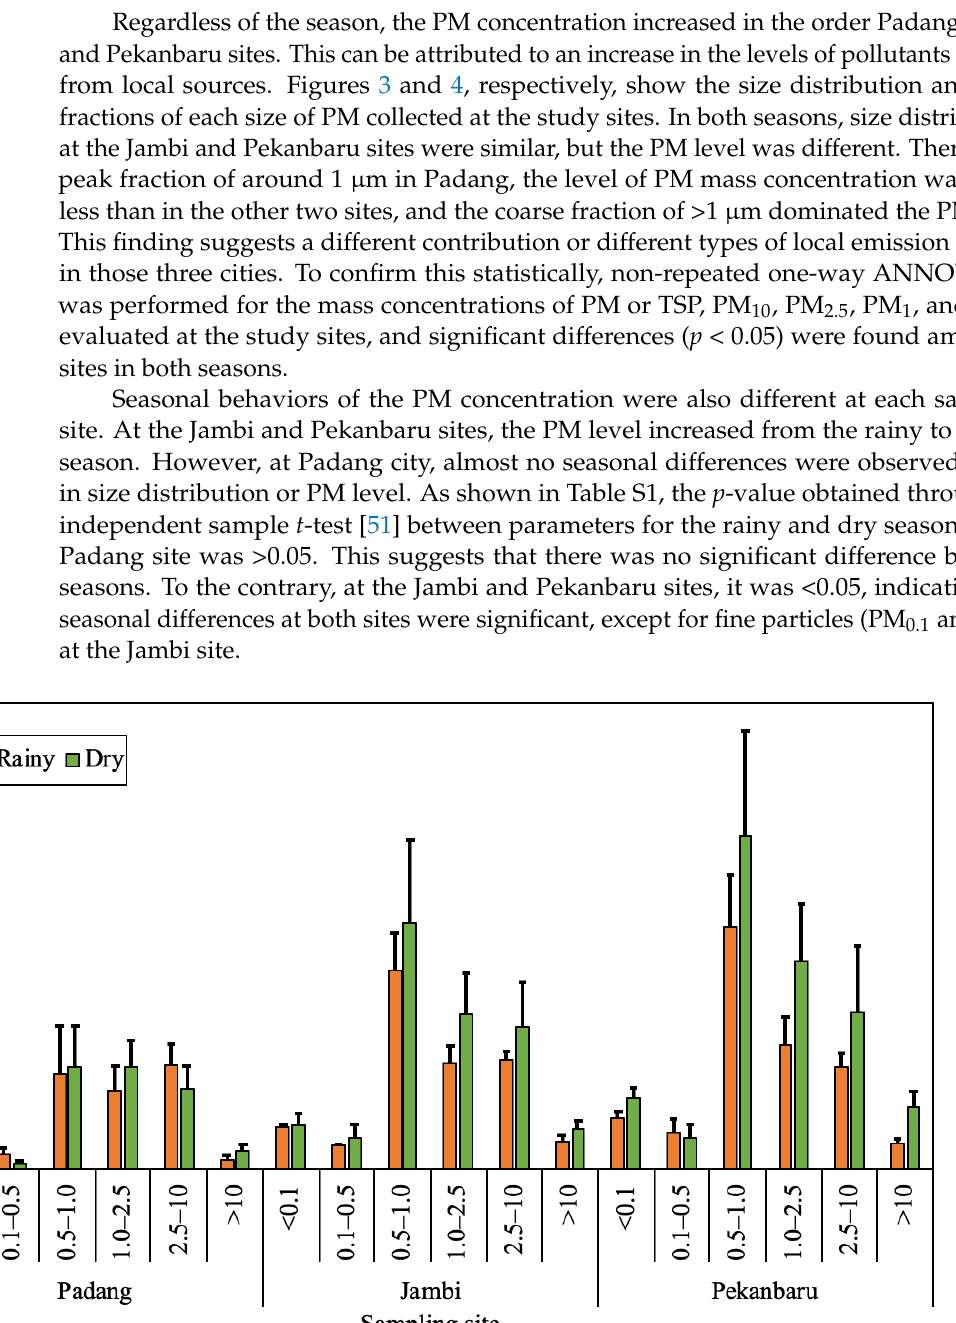
Figure 4. Size fraction of particles on a mass basis observed at study sites in Sumatra island. The influence of haze transport by air mass and meteorological conditions are also important parameters. Figure 5a–f shows air mass trajectories arriving at each sampling site plotted together with hotspots. The air mass approaching the studied sites in the rainy season (Figure 5a,c,e) was from the South China sea, indicating that the influence of peat- land fires may not be so serious, although a slight influence in long range transportation from the upper part of SEA cannot be excluded. Hence, differences in the chemical char- acteristics of PM between sites in the rainy season mainly appear to be from local emis- sions, except for agricultural open burning, as well as from meteorological conditions. At the Padang site, the air mass came from the ocean, or from the South China sea in the rainy season and from the Indian ocean in the dry season. This may be a reason for the